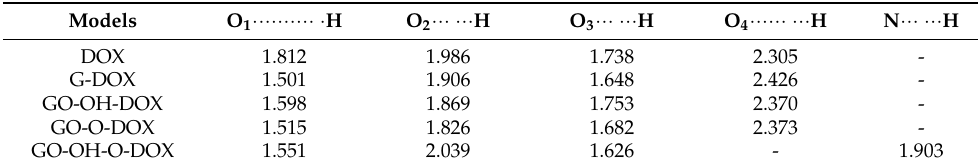
Table 2. Hydrogen bond length of DOX and graphene system molecules (Å). The annotation of O1 to O4 have shown in Figure